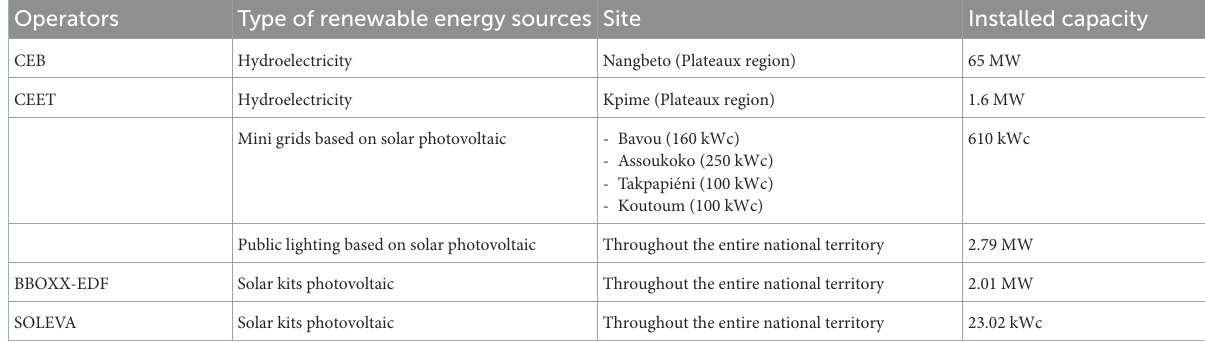
TABLE 8 National estimation of renewable energy in